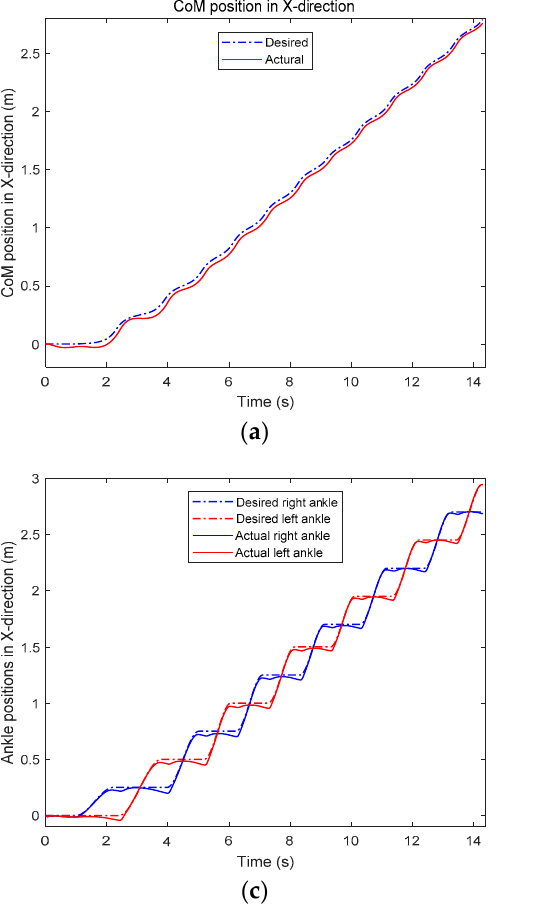
Figure 17. The difference between desired and actual trajectories: ( a ) CoM positions in X-direction; ( b ) CoM positions in Z-direction; ( c ) ankle positions in X-direction; ( d ) ankle positions in Z-direction.